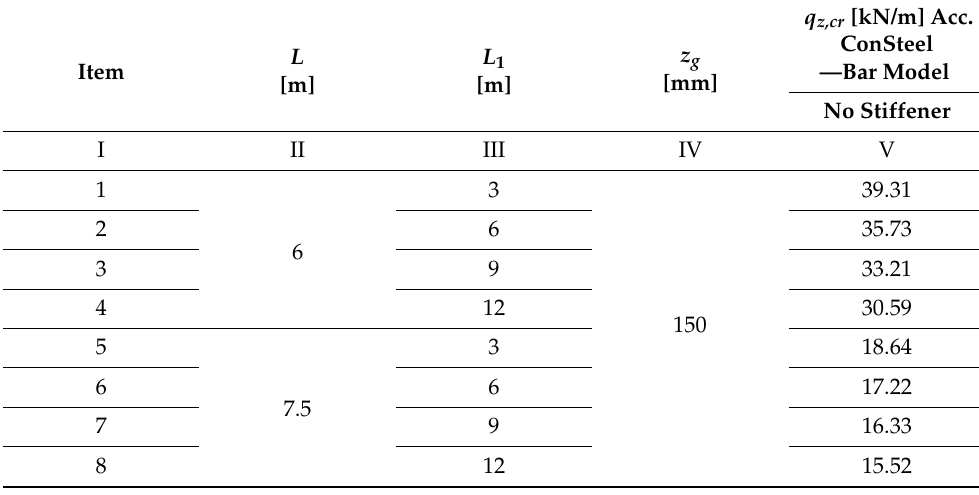
Table 2. The ECR ( q z,cr ) of H-type grillage from the condition of lateral torsional buckling of the main (critical) beam B–E, uniformly loaded ( z g = + h /2), from ConSteel (bar